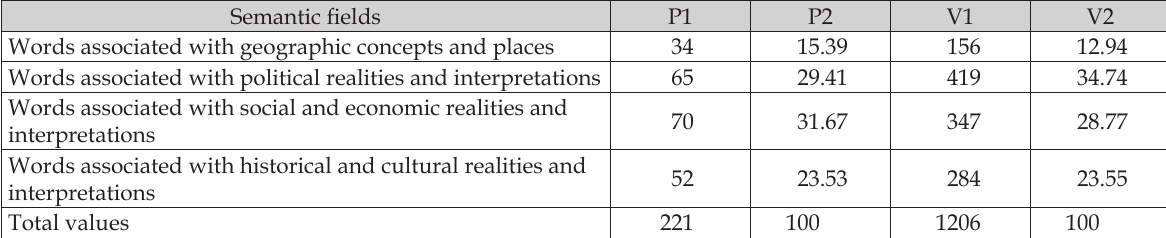
Table 1. Semantic fields shaping the concept of Europe after a word association test on students in training to be teachers in secondary education. Semantic fields Words associated with political realities and interpretations